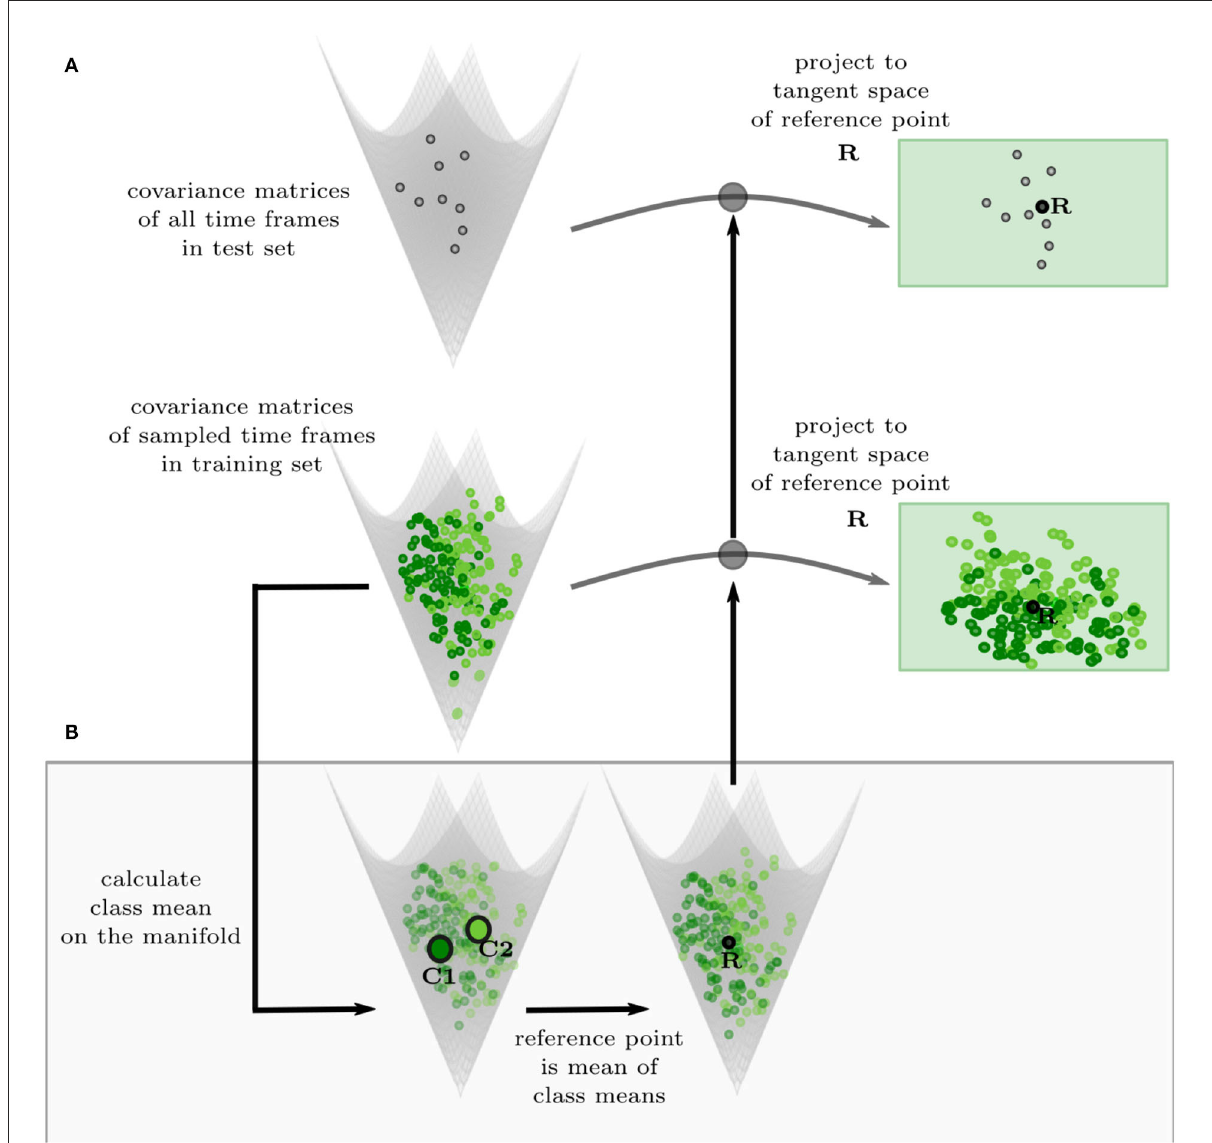
FIGURE3 Projection of covariance features to the Euclidean tangent space. (A) The test set (gray, top) and the training set (green, bottom) are projected to the same tangent space of the reference point R. (B) The reference point R is calculated by taking the Riemannian mean of the Riemannian class means of the training set on the manifold, ensuring that the reference point is balanced regarding the different